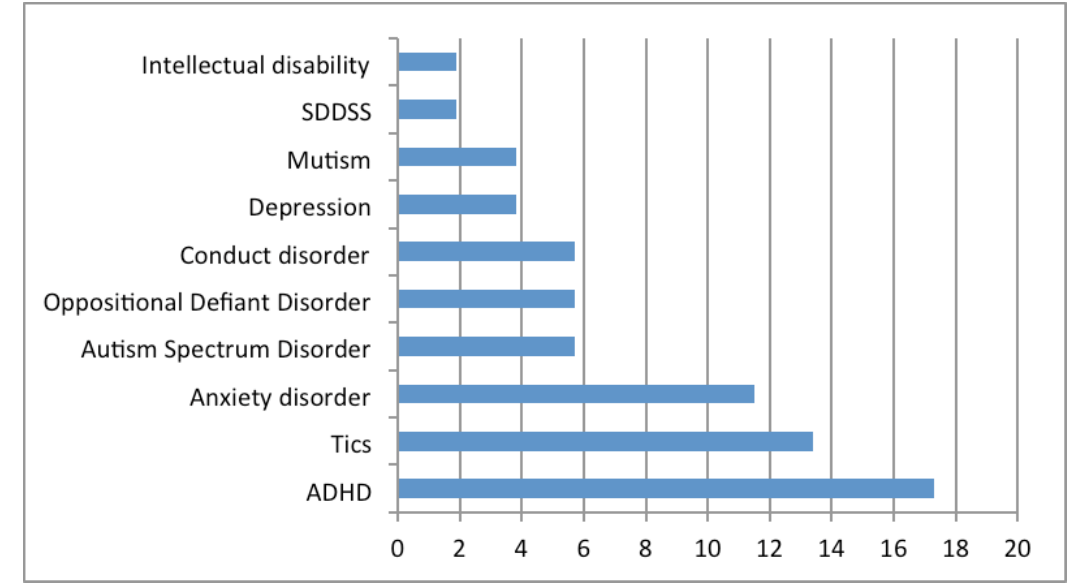
Figure 1. Proportions of varying behavioural and psychological symptoms of dementia among participants in this